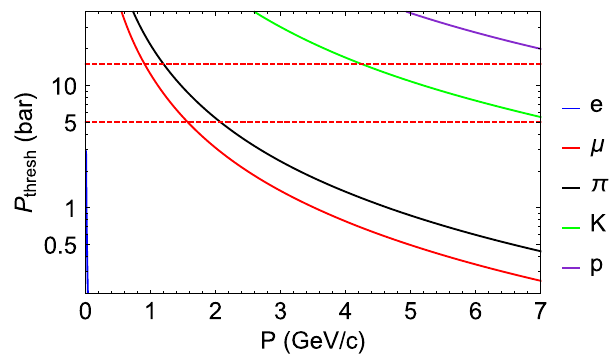
FIG. 15. Threshold pressures of CO 2 , for the two Cherenkov detectors used in H4-VLE, for all the different particle species. The two maximum pressures of the Cherenkovs, 5 and 15 bars, are drawn as horizontal red dashed lines in the plot. As summarized in Table I and discussed in the text, positrons are always tagged via the first (low-pressure) Cherenkov, while in the higher momenta, using the high-pressure Cherenkov protons and kaons can be also identified.